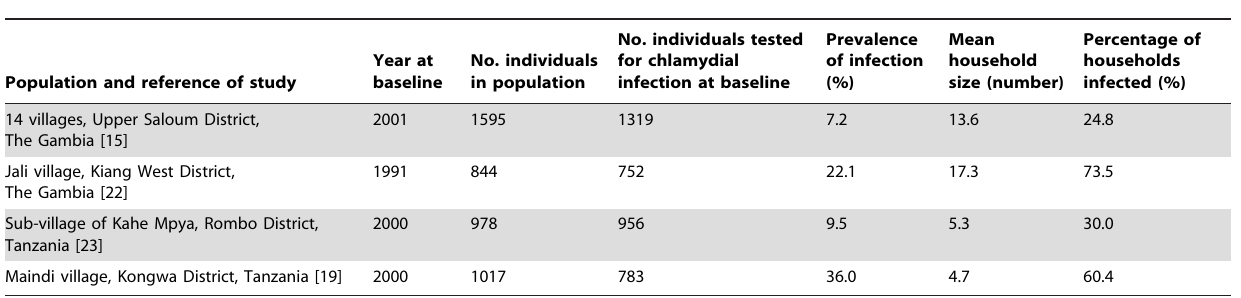
Population and reference of